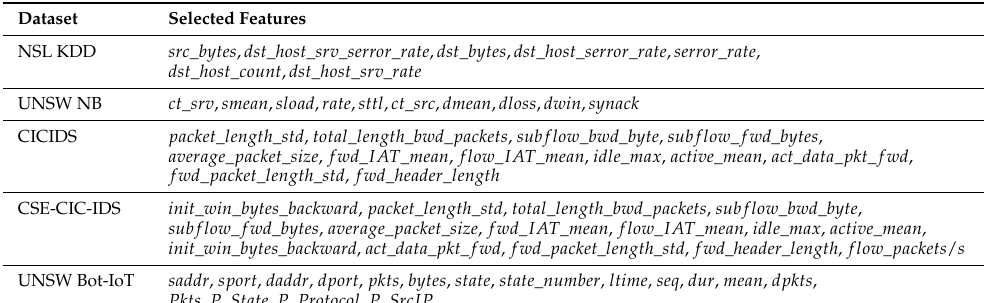
Figure 6. Epoch vs. Accuracy: ( a ) NSL KDD, ( b ) UNSW NB, ( c ) CICIDS, ( d ) CSE-CIC-IDS, ( e ) UNSW Bot-IoT. Table 2. Selected features using LPCO